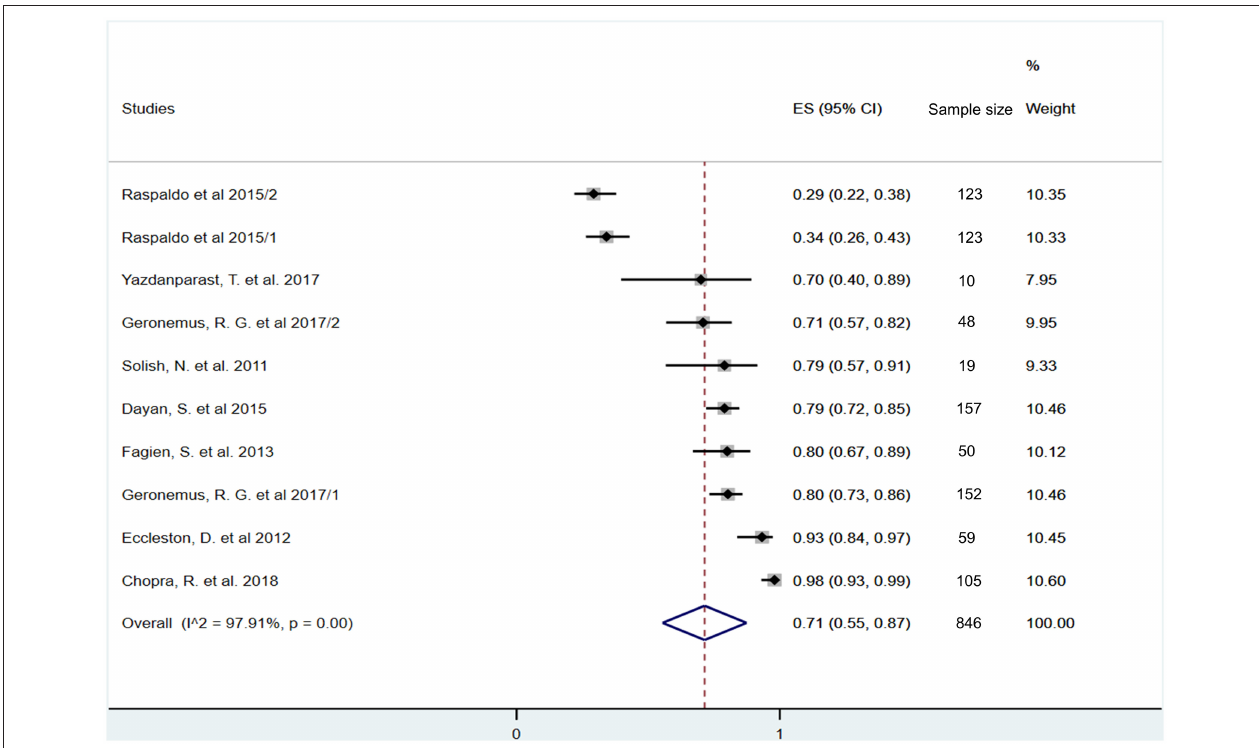
FIGURE 5 | Estimate of overall rate of responders at 3 months after treatment. Overall, 71% (95% CI: 55–87%) of included participants had at least one grade improvement on a validated lip fullness scale after 3 months of initial